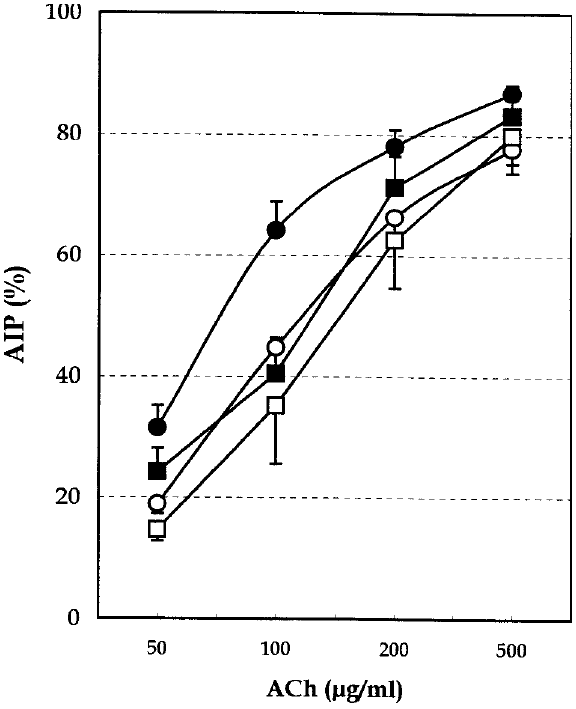
FIG. 3. Influence of milrinone (30mg/kg) on cumulative dose± response curve for acetylcholine (50, 100, 200 and 500 m g/ml) in anaesthetized guinea-pigs, 24h after ovalbu- min challenge (OA). Sensitized guinea-pigs were treated orally with milrinone (30mg/kg), 24 and 3h before the antigen challenge (OA) or saline exposure (SAL). Symbols represent control with ( h ) or without ( s ) milrinone and after antigen challenge with ( j ) or without ( d ) milrinone ( n =6± 20). Significant difference between OA and milrino- ne+OA is P <0.05. No significant difference is noted between SAL+milrinone and OA+milrinone.